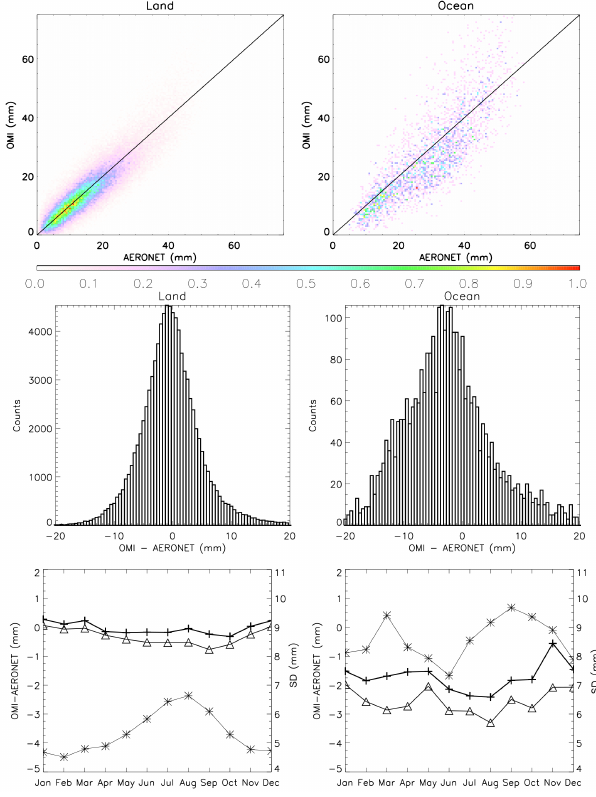
ocean derived from all the paired version 1.0 OMI and AERONET data at all suitable AERONET stations from 1 January 2005 to 31 December 2009. Results are shown for 0.5mm × 0.5mm bins, with the largest binned value normalized to 1. The black line in each panel corresponds to 1:1. Middle: histograms of version 1.0 OMI − AERONET derived from the same data as those used in the top row. The counts correspond to 0.5mm bins. Bottom: mean (tri- angle, left axis), media (cross, right axis), and standard deviation (star, right axis) of version 1.0 OMI − AERONET as functions of month for (left) land and (right) ocean